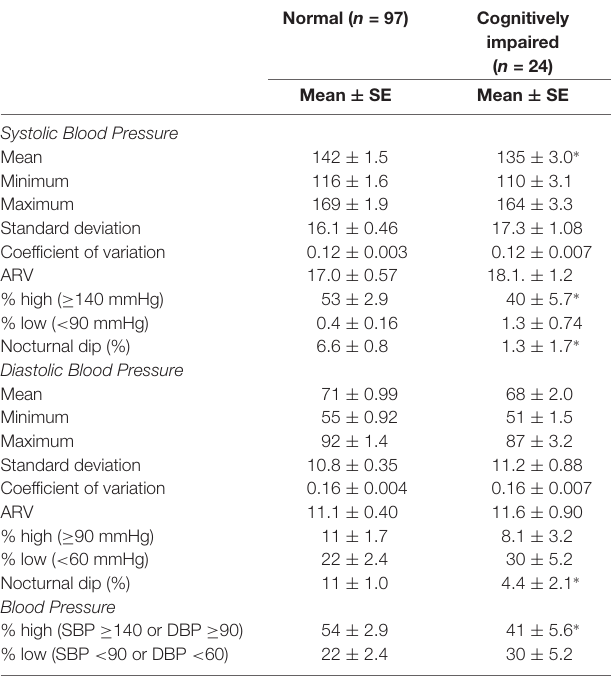
TABLE 3 | Daytime BP levels and variability measurements by cognitive status. TABLE 4 | Nocturnal dipping by cognitive